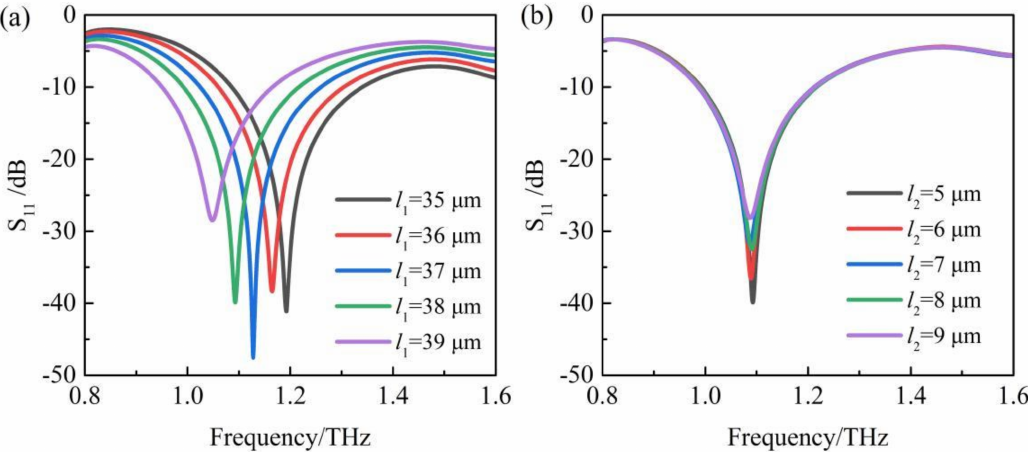
Figure 4. ( a ) Relation between the reflection coefficient and frequency of the absorber for different widths ( l 1 ) of the VO 2 square ring resonator. ( b ) Relation between the reflection coefficient and frequency of the absorber for different hole widths ( l 2 ) of the VO 2 square ring